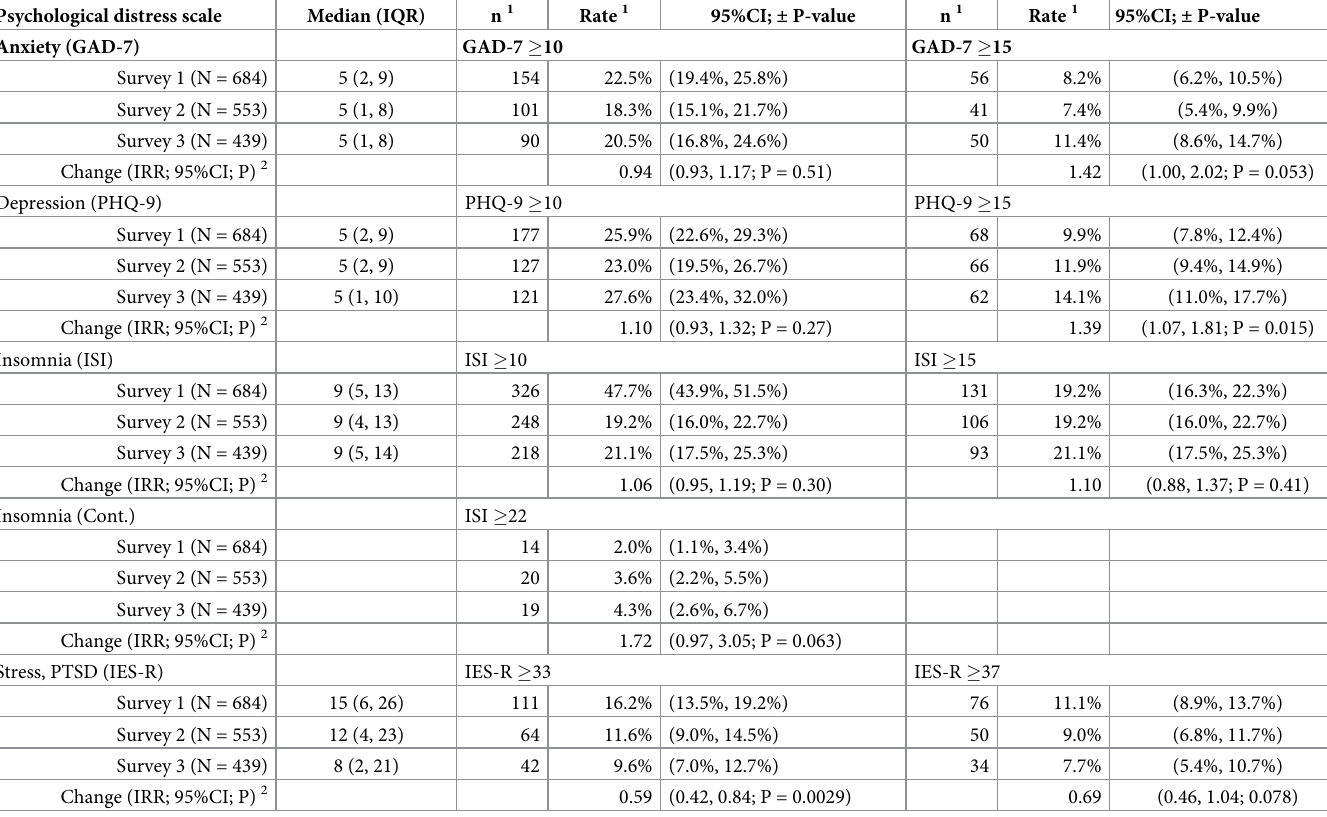
Table 2. Prevalence of psychological distress in the surveys, and change in the rates of the distress over 1 year. Psychological distress